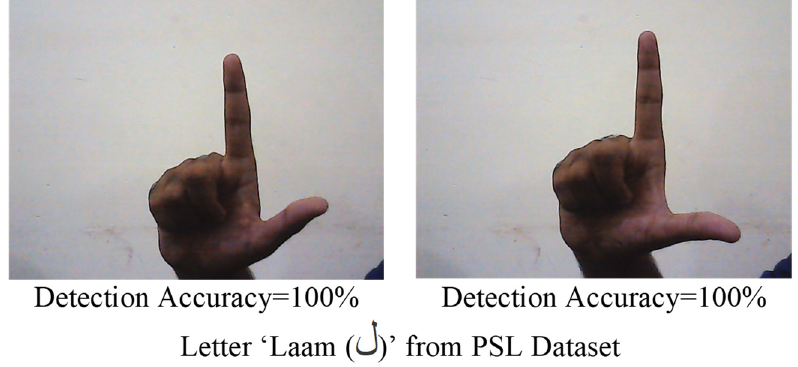
Figure 15. Processing variation in same hand gesture scenario 2.